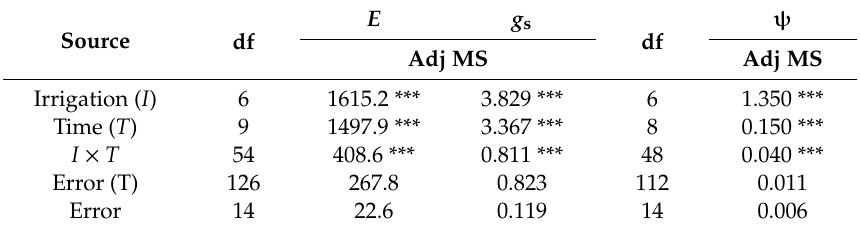
Table 2. Repeated-measures ANOVA for main effects and interactions on the physiological traits.